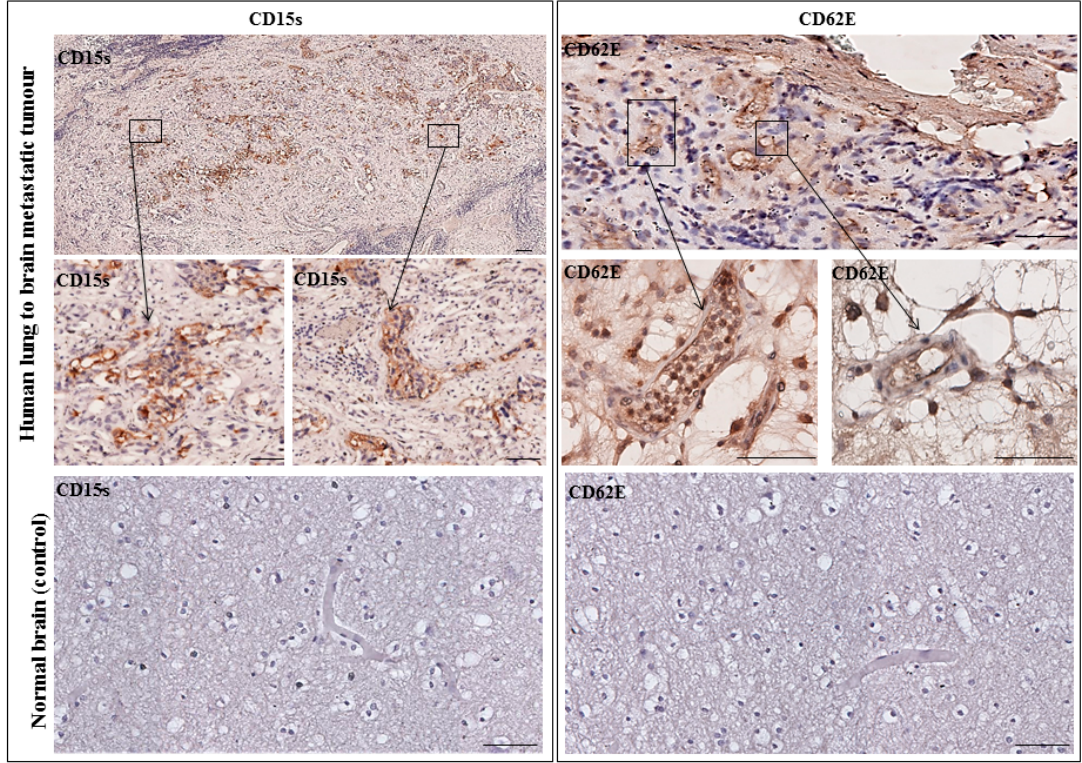
Figure 6. Representative immunohistochemistry images from one patient with lung–brain metastasis. ( Left panel ) CD15s was detected in tumour core and infiltrated into non-neoplastic host brain tissue. No expression was seen in a normal brain section. ( Right panel ) CD62E was expressed on the inner lining of brain endothelial cells with no expression seen in normal brain sections. Images were obtained using an Ariol microscope (Leica, Wetzlar, Germany) at 20× and 40× magnification. Scale bar = 20 µm. n = 1.